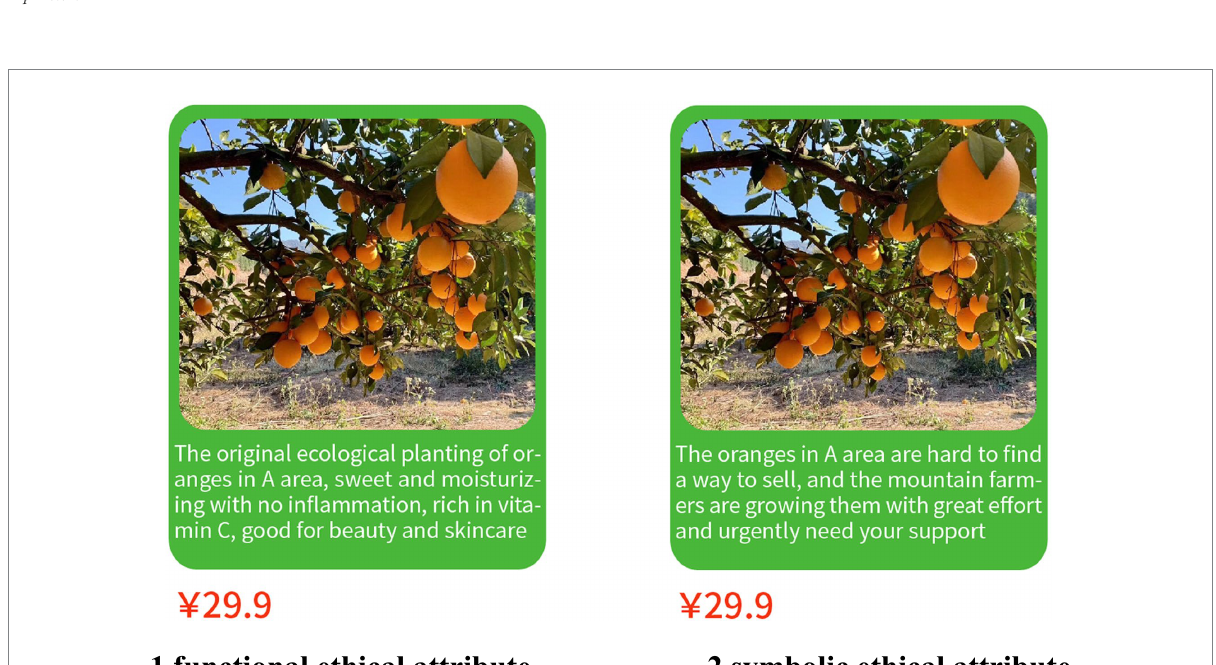
FIGURE 3 Image of ethical attributes of farmer-assisting agricultural products in Study